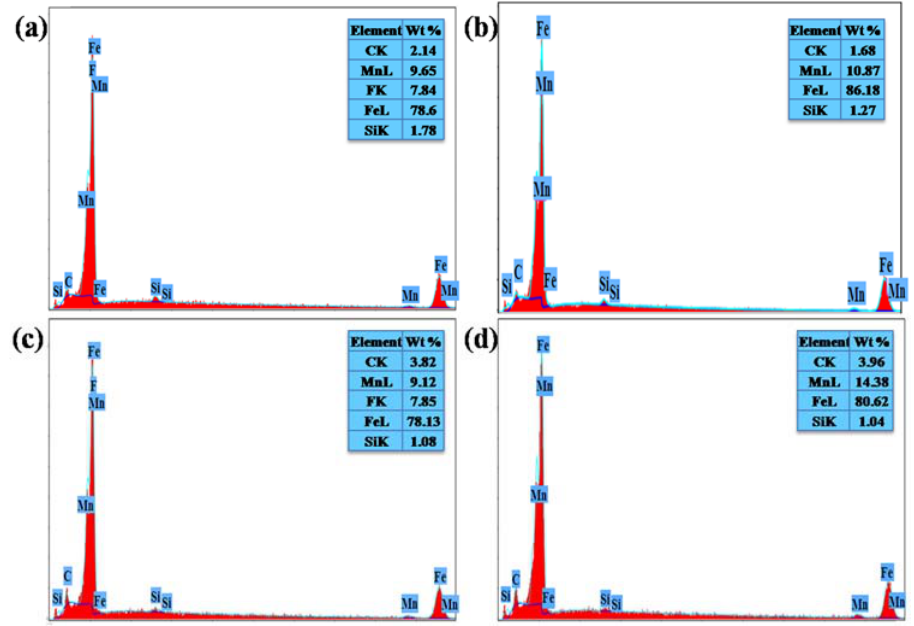
Figure 4. EDS spectra of pearlite phase in ( a ) non-treated, ( b ) TMSA, ( c ) TMDA, and ( d ) TMTA treated AISI 1345 steel.